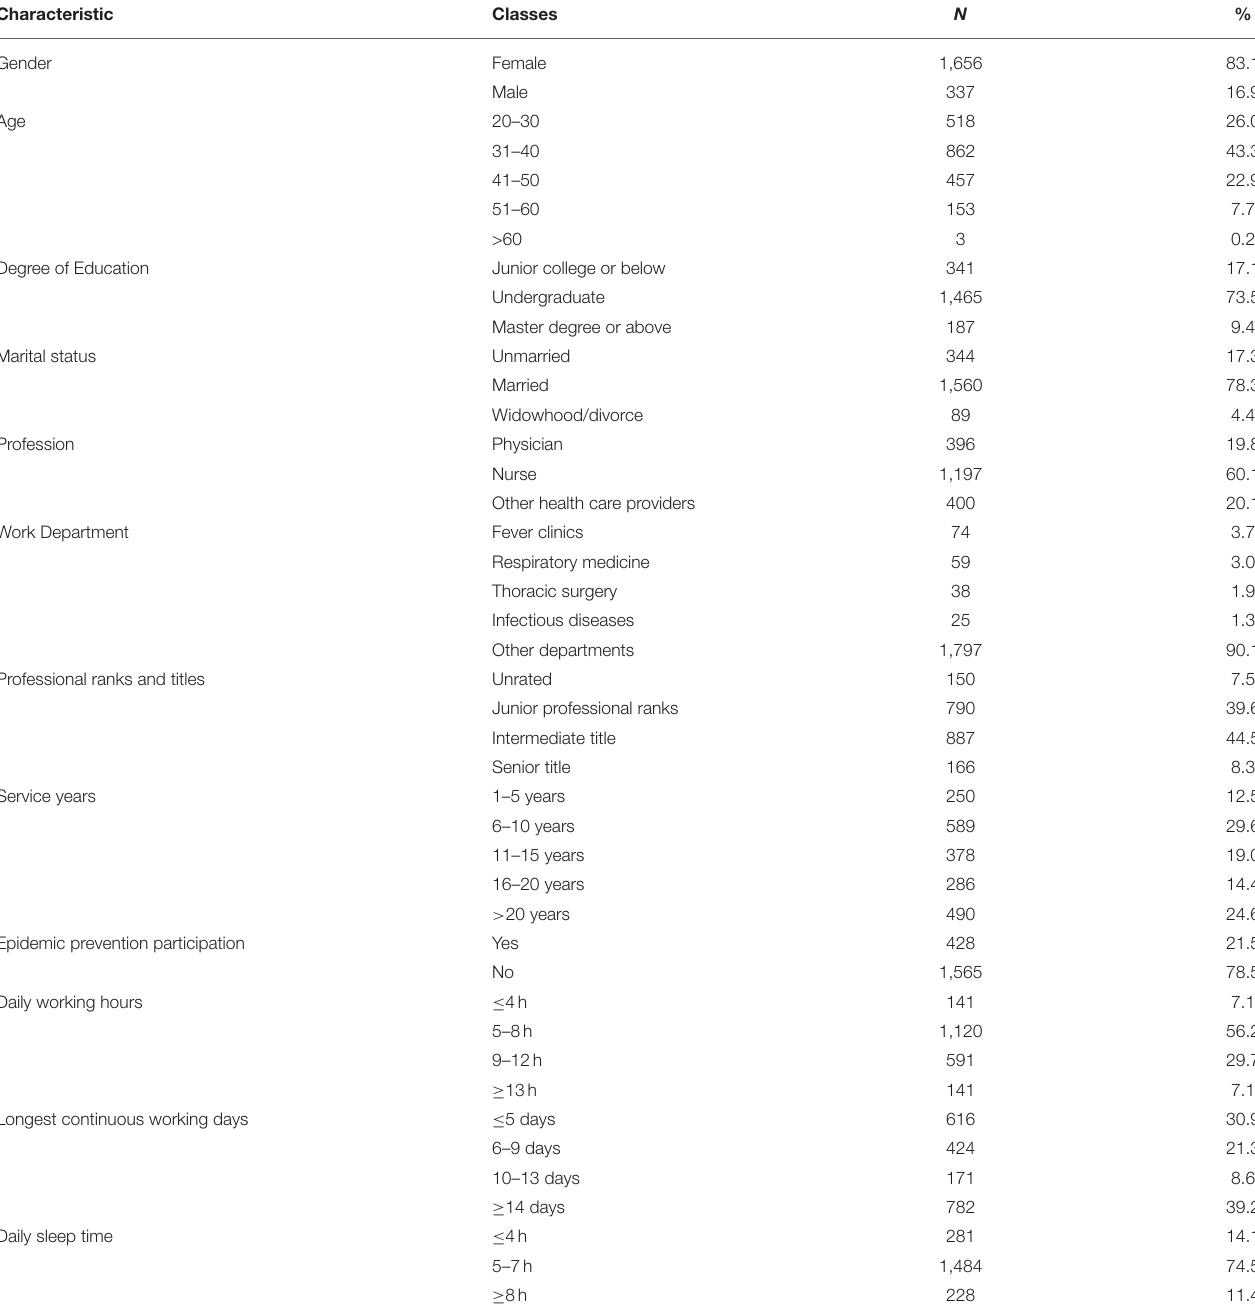
TABLE 1 | Demographic characteristics of the respondents ( n =